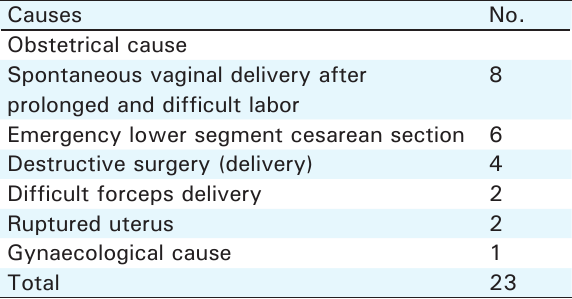
Table 2. The obstetrical details and causes of